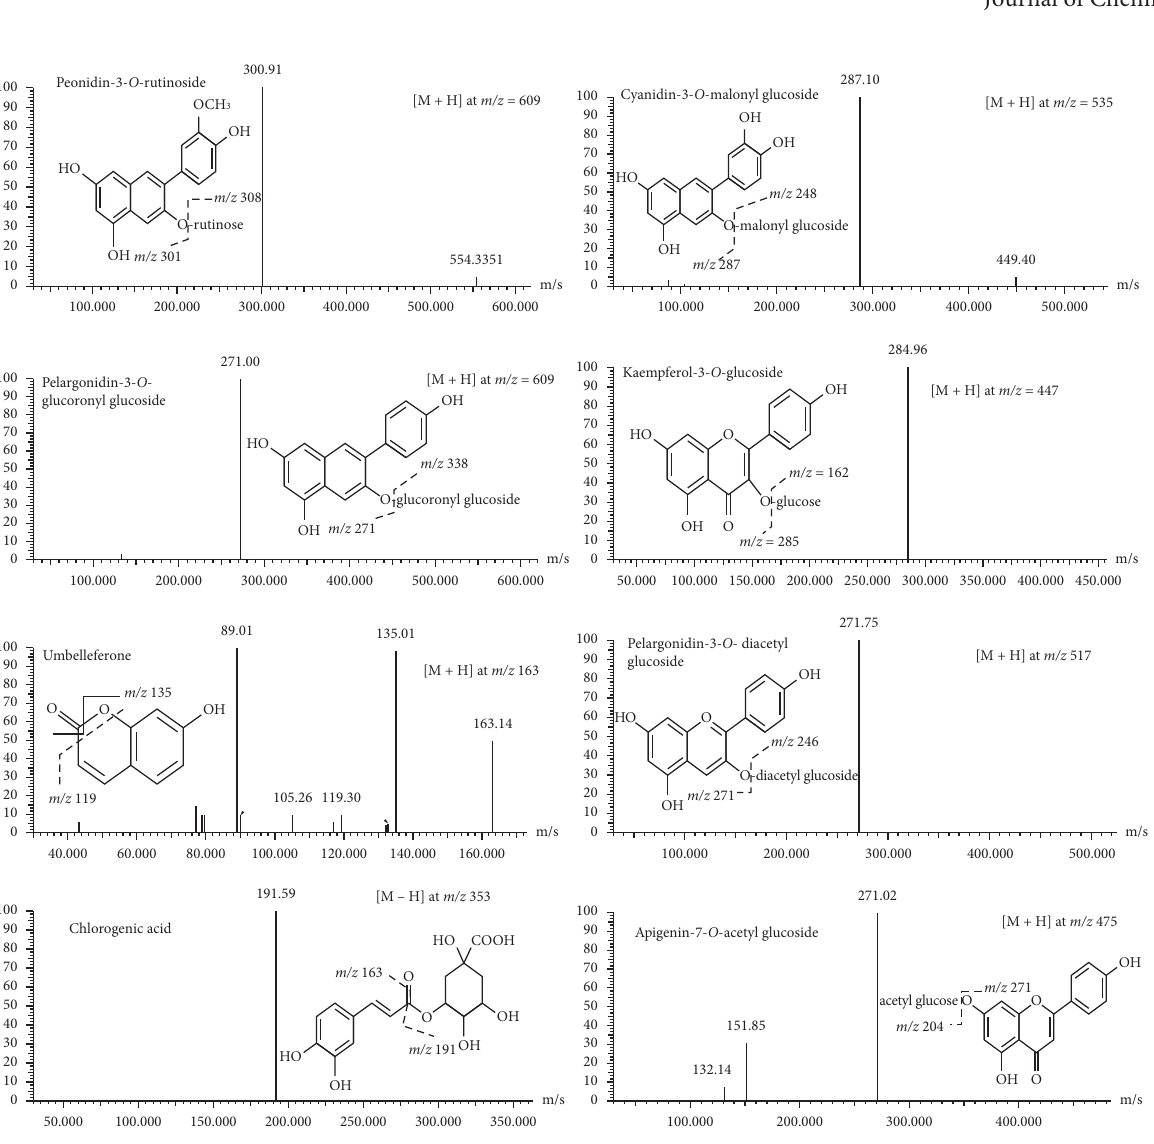
Figure 2: UPLC-ESI-MS/MS fragmentation of some identified compounds in E. cardamomum aqueous Table 2: Inhibition assay of pancreatic lipase activity of Elettaria cardamomum L. (Card A) at different concentrations.